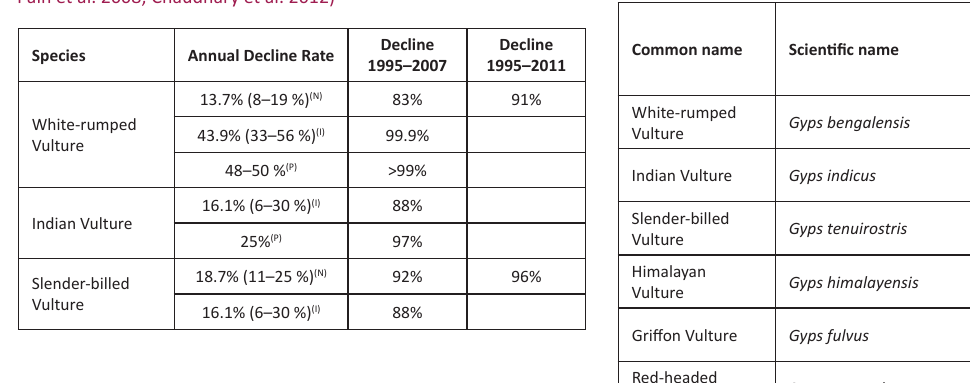
Table 3: Conservation Status of Nepal’s Vultures. Adapted from (BirdLife International, 2011; DeCandido, et al., 2012; Government of Nepal, 2009; IUCN, 2012h; Subedi & DeCandido, unpub.)